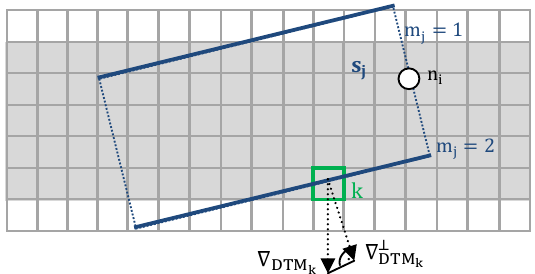
Figure 2. The segment of a junction point (white circle) contributes to the data energy by the sum of the components of the gradients in the direction of the normal vector of each pixel k of the lateral edges. (The grey pixels indicate a channel / river in the